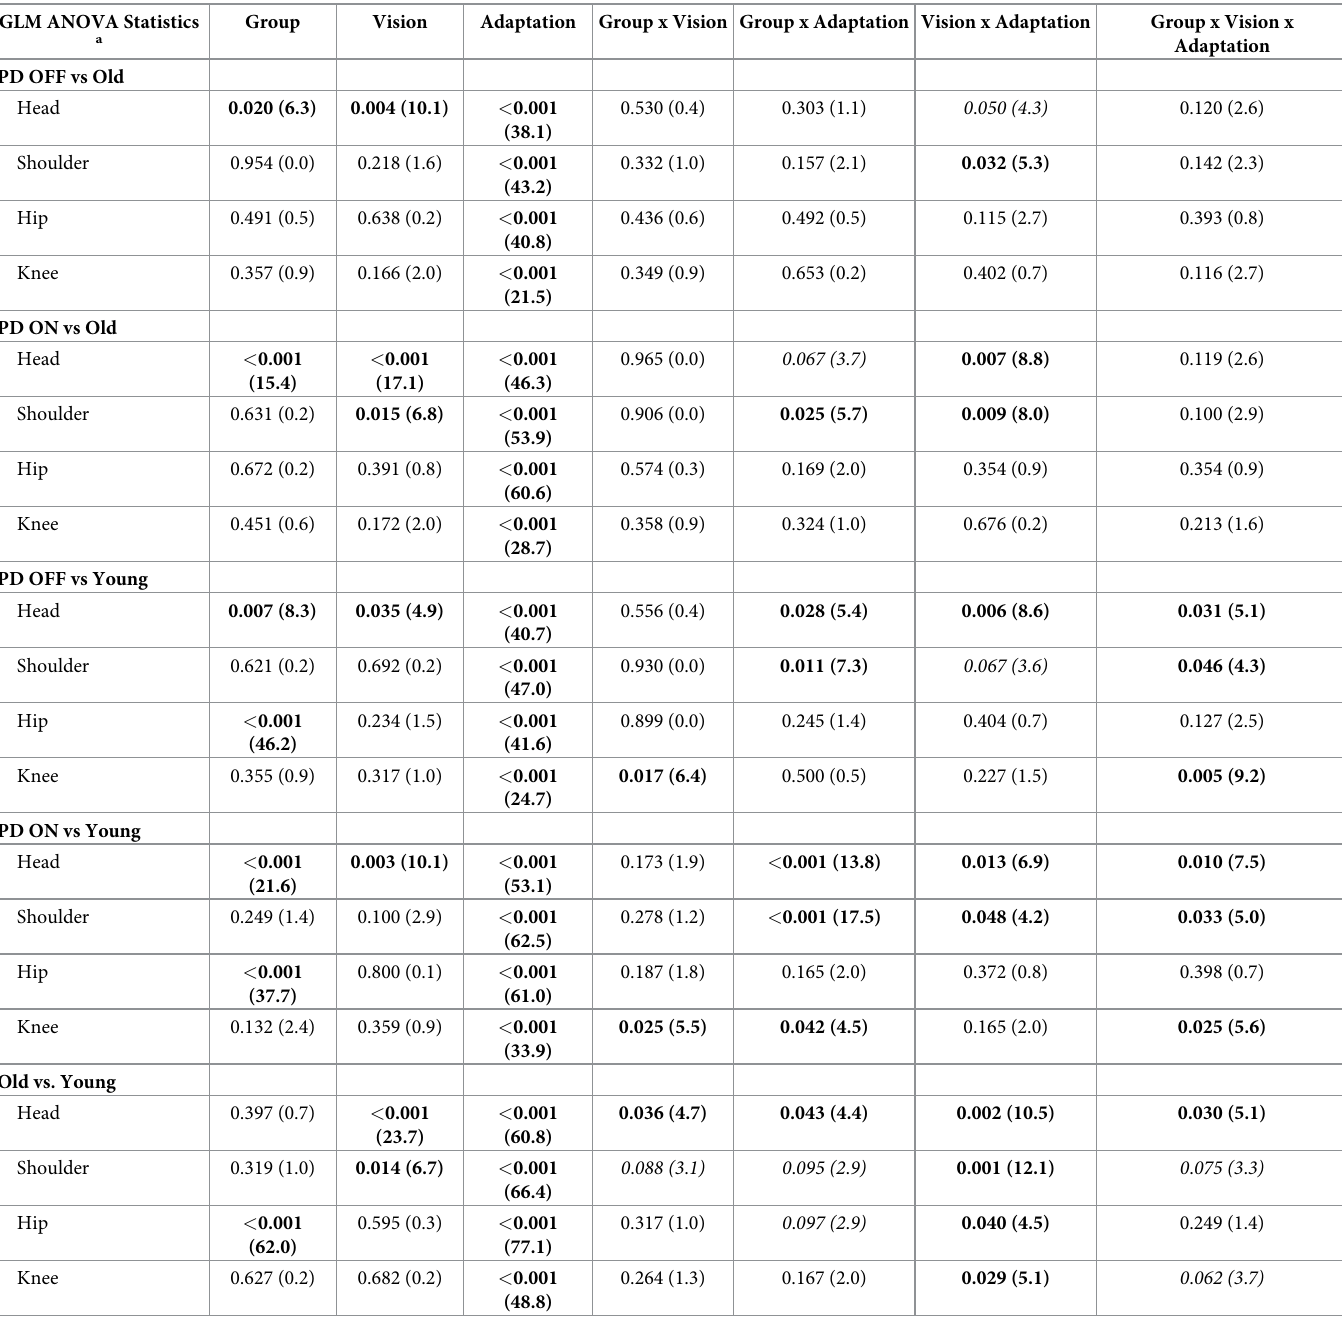
Table 3. Group, vision and adaptation effect on the body posture.